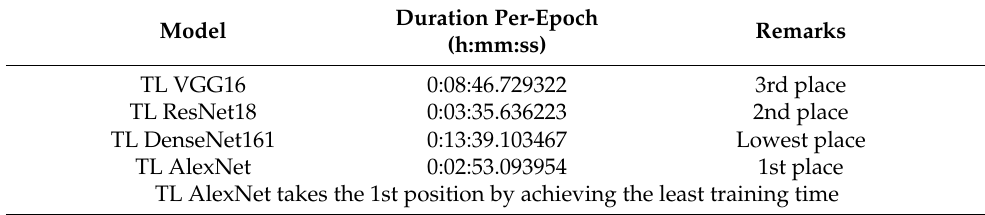
Table 5. Training time per-epoch of TL models.